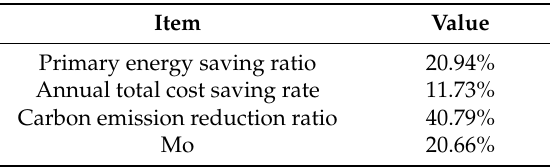
Table 12. Annual performance value of RES–CCHP system.